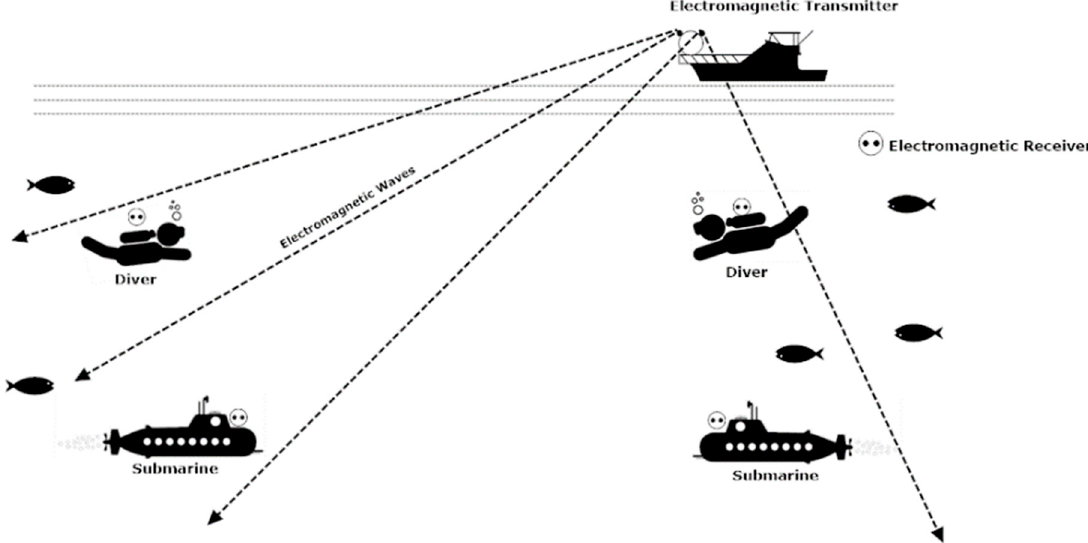
Figure 5. Electromagnetic tracking-based wireless communication.